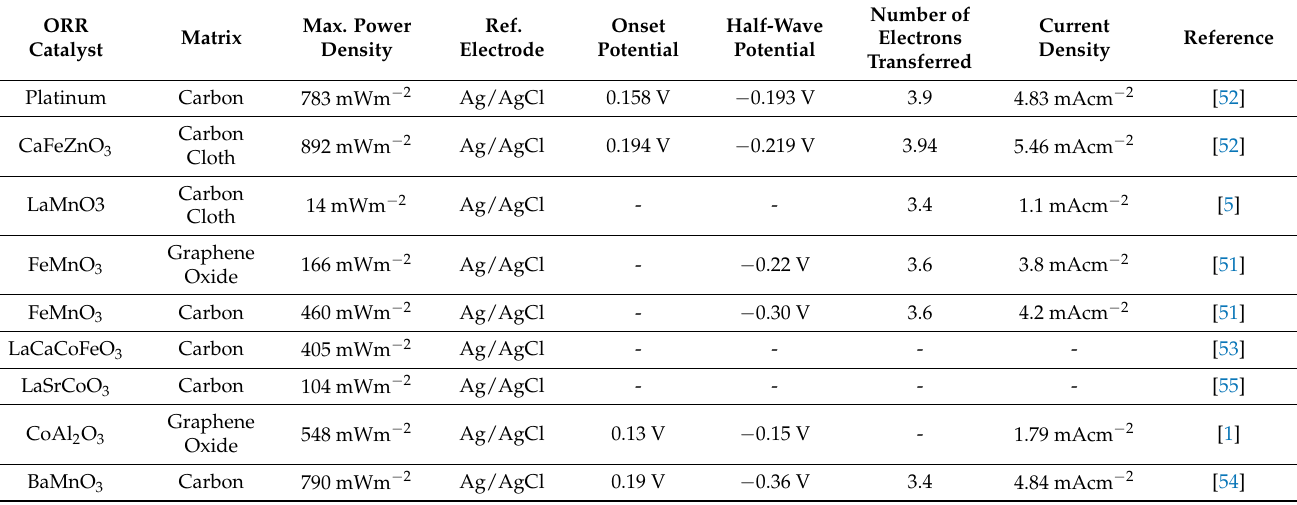
Table 1. The kinetic data of Pt and the various perovskite-type oxides used in